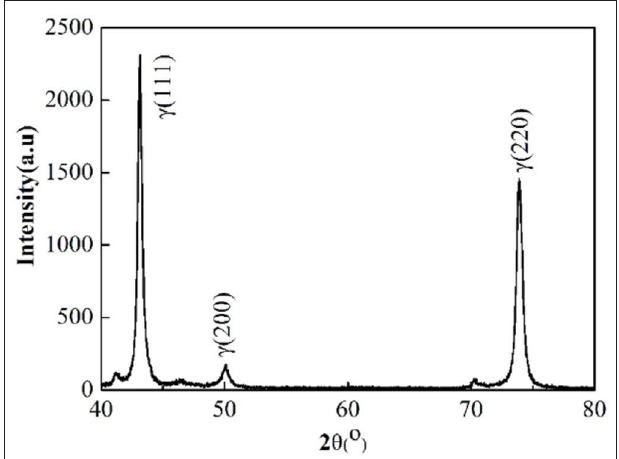
FIGURE 1 | X-ray patterns of the cold-rolled sample showing single-phase